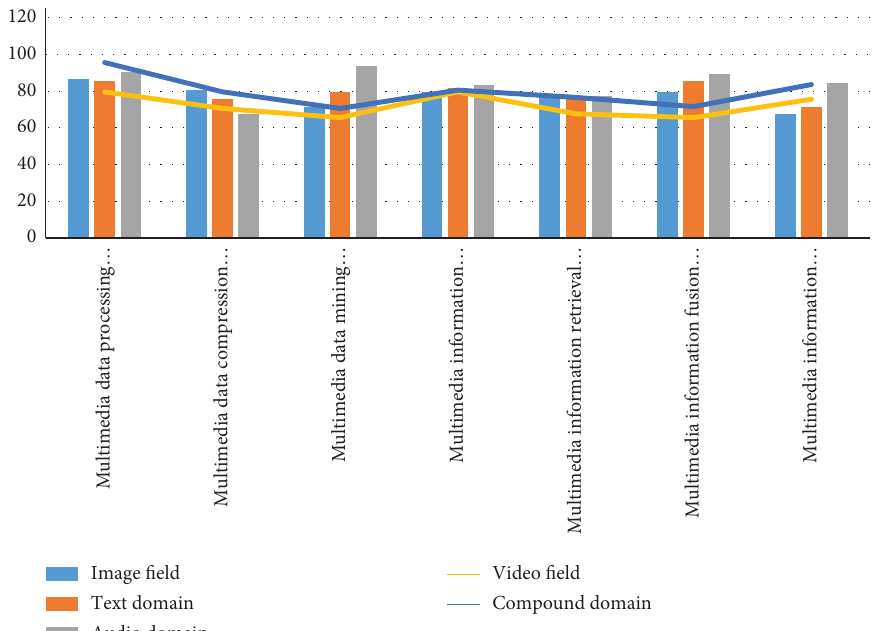
Figure 10: Comparison of application felds of multimedia data processing technology and related technologies.